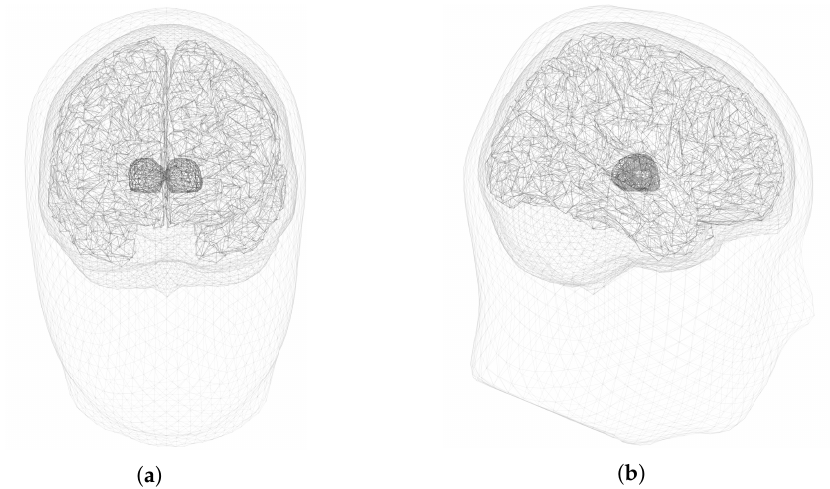
Figure 2. Geometrical model with four layers (scalp, skull, brain and thalami). ( a ) Frontal. ( b ) Sagittal.